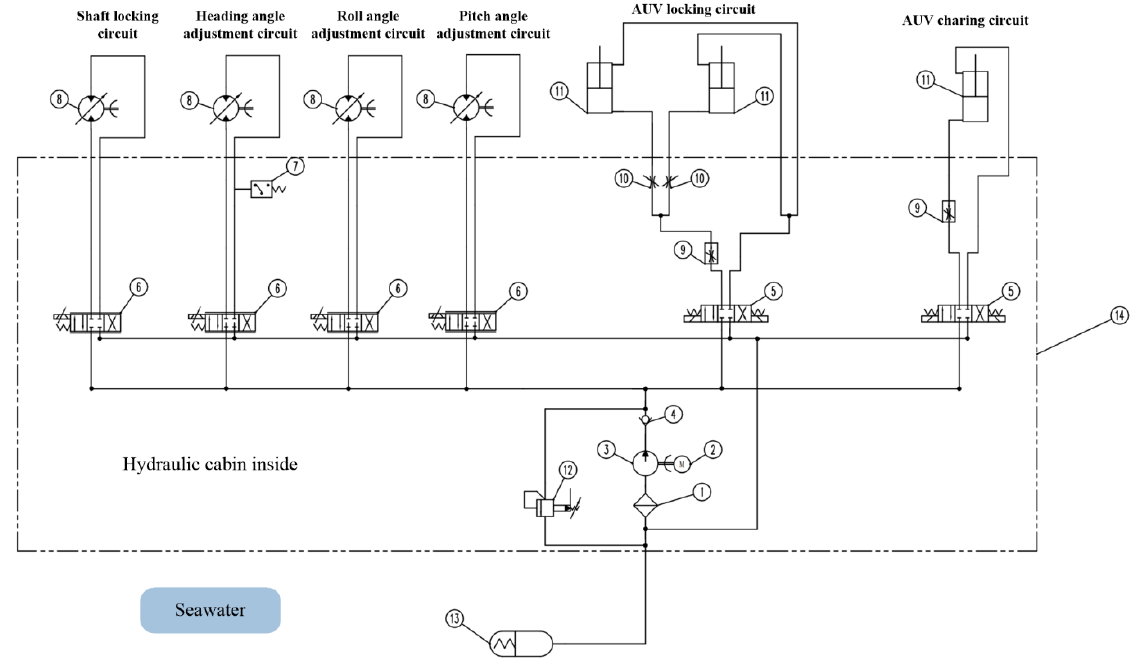
Figure 5. Designed underwater hydraulic system of the AUV docking device: 1. filter; 2. electric